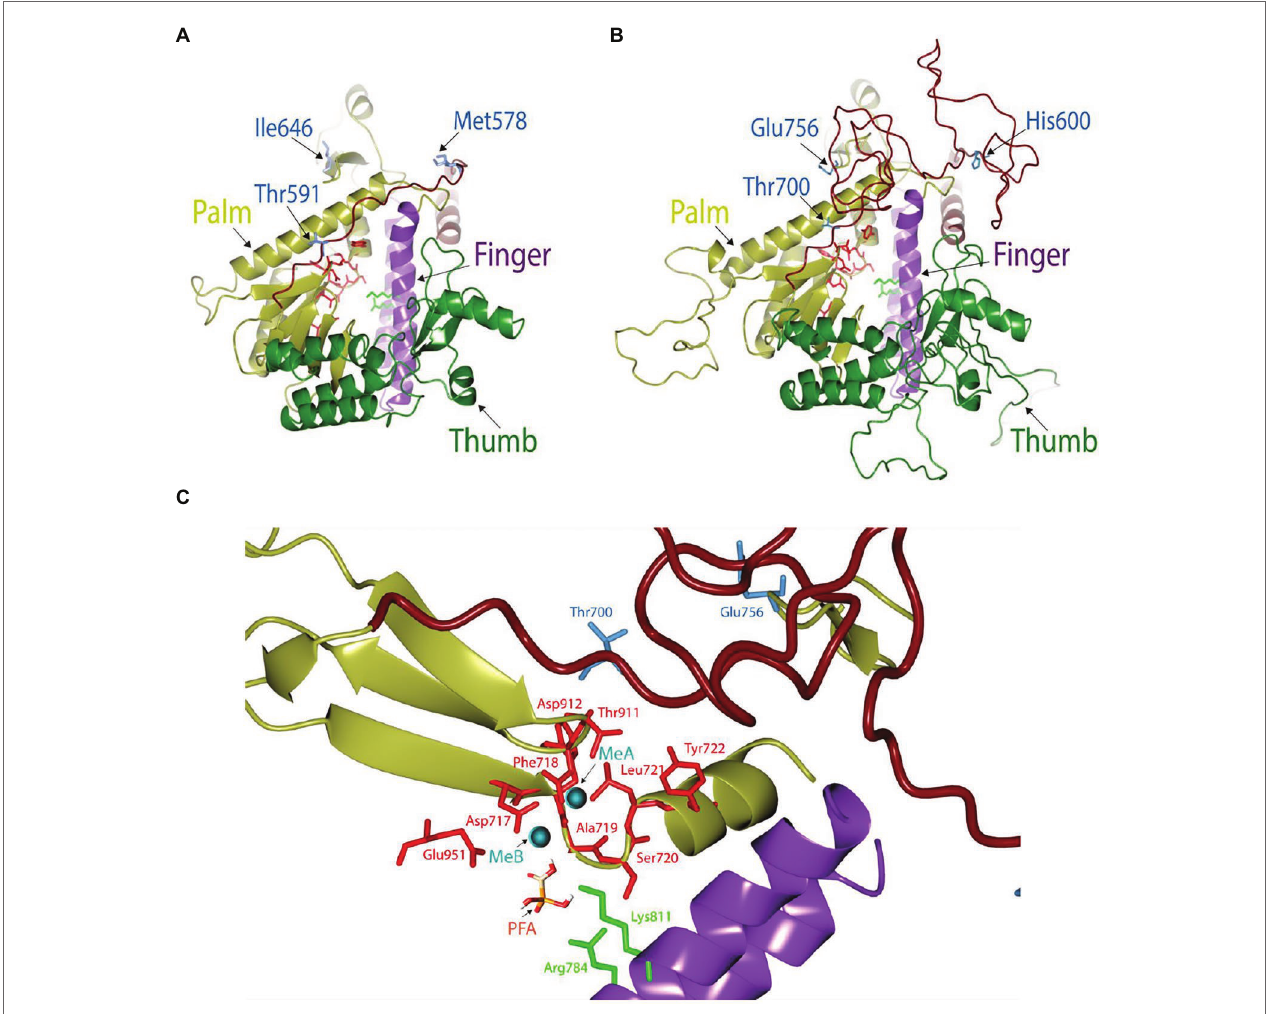
FIGURE 6 | Structural view of the catalytic domain in HCMV DNA polymerase. (A,B) Comparison of the catalytic domains in yeast (A) and HCMV (B) DNA polymerases. Thumb (green), palm (yellow), and finger (purple) domains in each structure are drawn for comparison. The loop in the palm region is colored in brick. Key resides in the mutation study (blue), active site residues (red), and two basic residues involved in FOS binding in the finger domain (green) are displayed as stick models. (C) Close-up view of the FOS binding pocket of HCMV DNA polymerase in the presence of metal ions (MeA and MeB) and FOS. FOS (PFA) engages in electrostatic interaction with amino acid residues R784 and K811 (green) in the finger domain and also coordinate with metal ions (cyan) that are stabilized by acidic amino acid residues (red). Mutant site and active site amino acid residues are displayed as blue and red stick models,